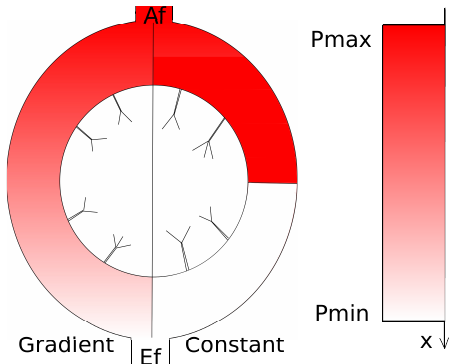
Figure 9. Schematic view of the SCS pressure distribution for two types of pressure boundary conditions (1) gradient and (2) constant. Branches emanating from the inner SCS circle represent the input and output edges of the network.